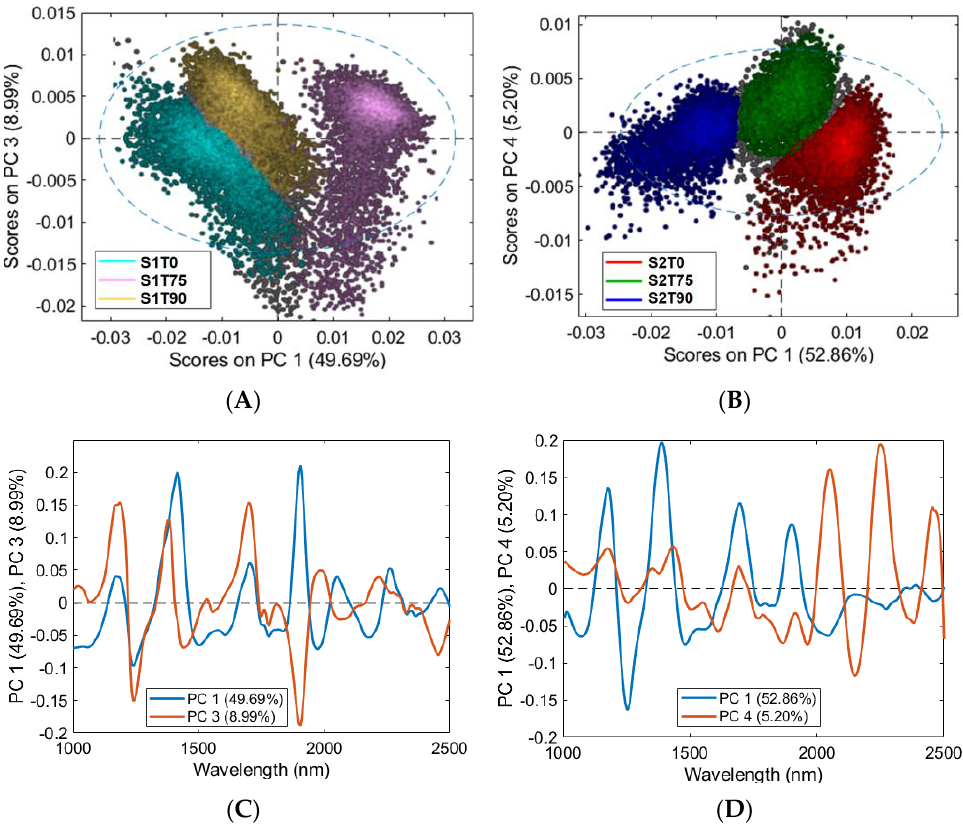
Figure 7. PC1–PC2 score plot ( A , B ) and loading plot ( C , D ) referred to the selected samples.